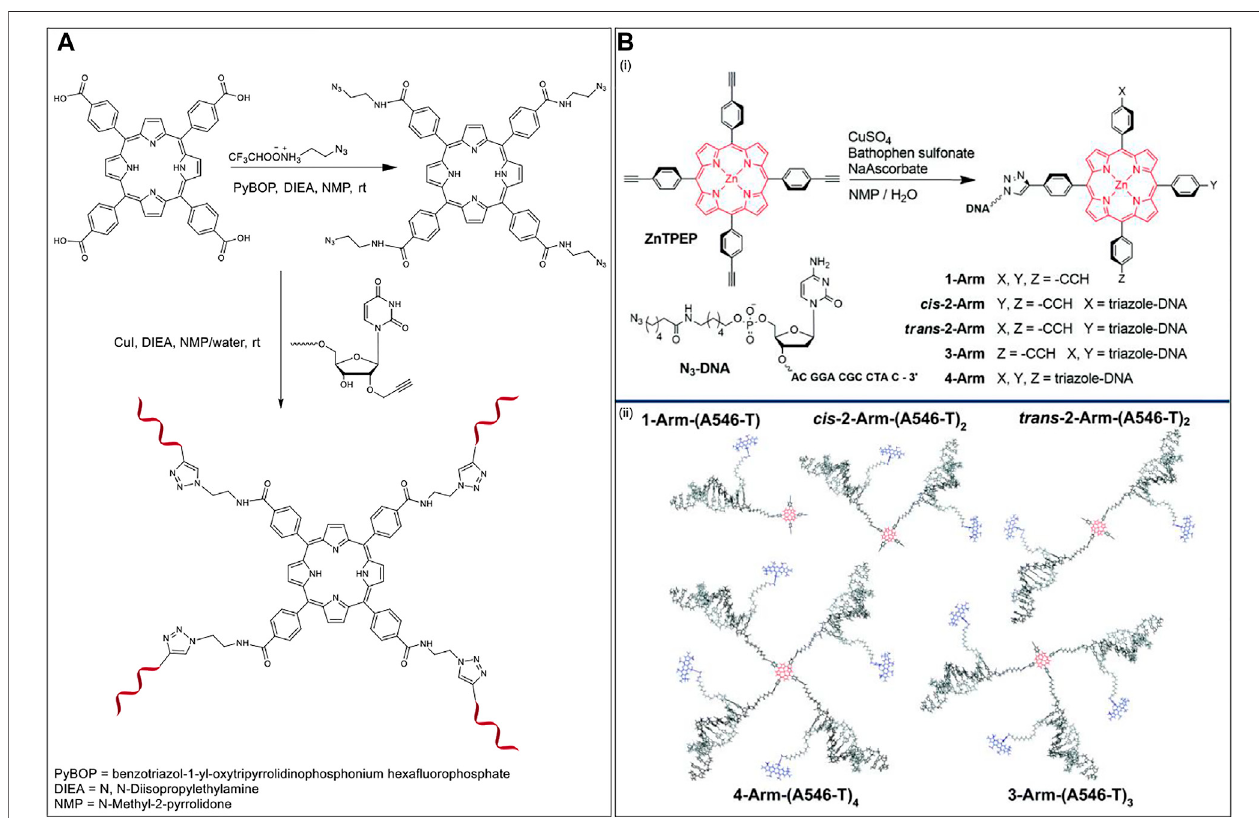
FIGURE6|(A) SynthesisofmultibranchedPorphyrin-ONscaffold(Clavéetal.,2014). (B) (i)Schemeforthesynthesisofmultiarmporphyrin-DNAhybrid via CuAAC (ii) Hybridization of the porphyrin-DNA hybrids with A546 bearing complementary strands offers various FRET-compatible structures. Reprinted with permission from (Anderson et al.,